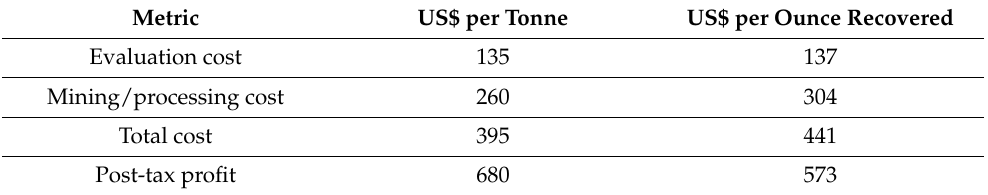
Table 15. Cost and profit per tonne and ounce. Values rounded to the nearest whole